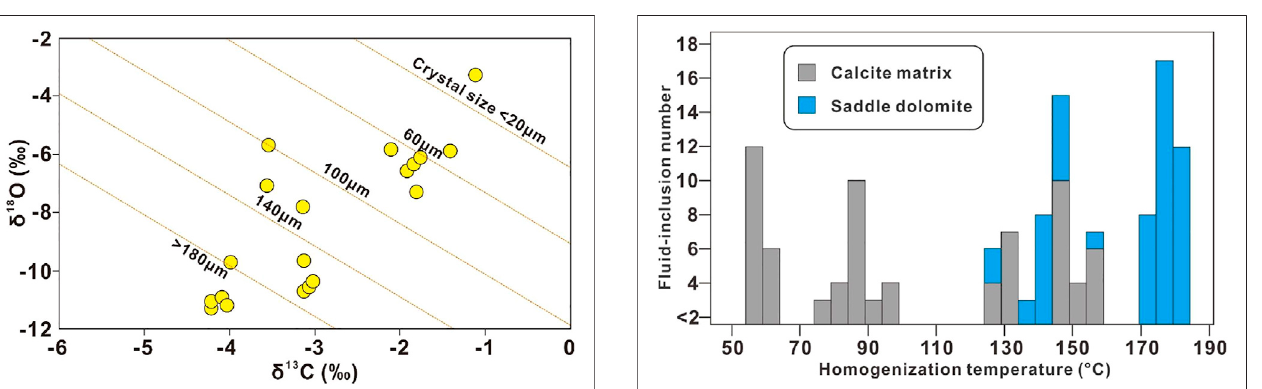
FIGURE 9 | Histograms showing homogenization temperatures of the calcite matrix and saddle dolomite in the studied interval.